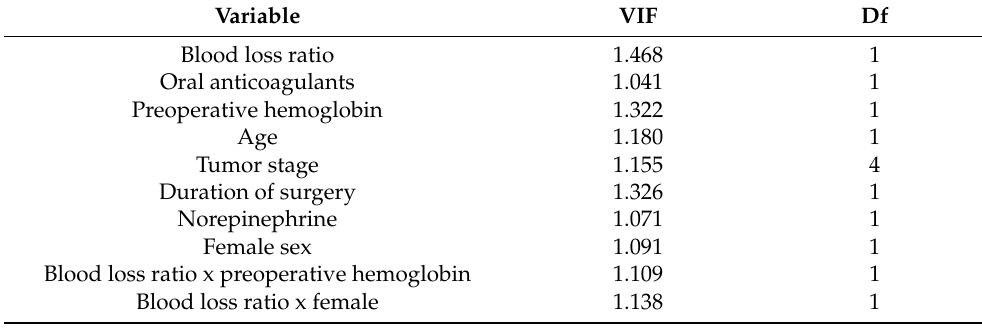
Table A1. Model diagnostics variance inflation factor (VIF) >10 indicating the presence of multicollinearity.